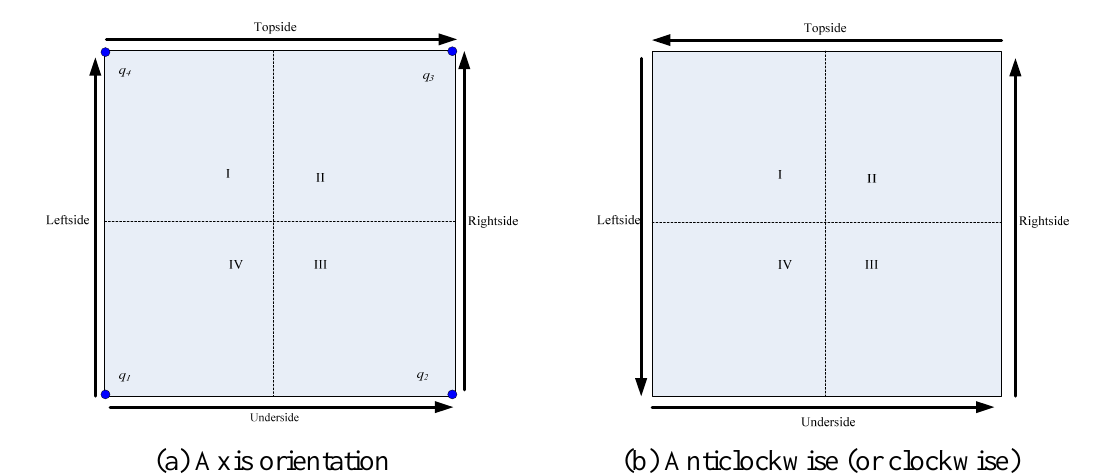
Figure 6. Illustration of radio radius calculation when deploying 4 sink nodes in work area. (a) The axis orientation mode. (b) the Anticlockwise (or clockwise) mode. Dashed lines refer to the border of quadrant area while solid lines with arrowhead refer to the axis orientation of radio radius calculation.